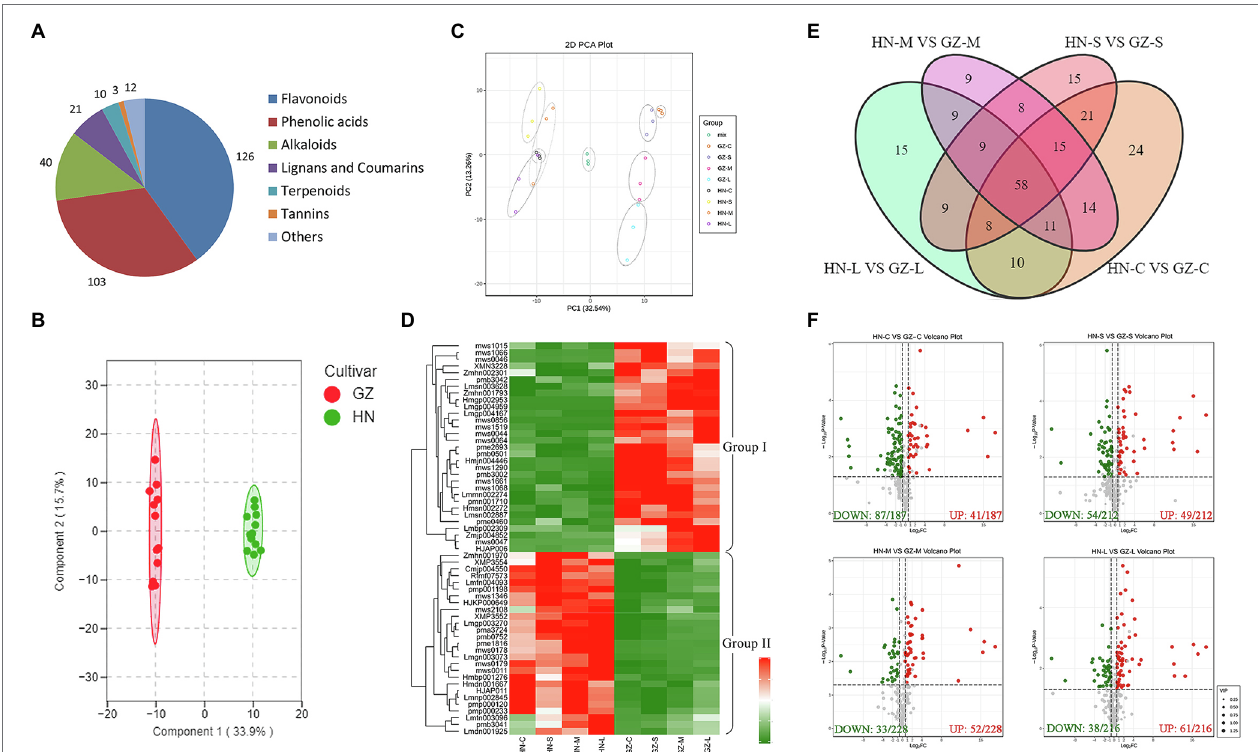
FIGURE 4 | Metabolome differences between GZ and HN under salt treatments. (A) The classification of 315 secondary metabolites. (B) Principal component analysis (PCA) scores plot. (C) OPLS-DA score plot. (D) The heatmap of the common DAMs. (E) Venn diagram of the DAMs. (F) Volcano plot analysis on the DAMs under normal conditions and salt stress. Metabolite accumulation are represented by red spots (up-regulated), green spots